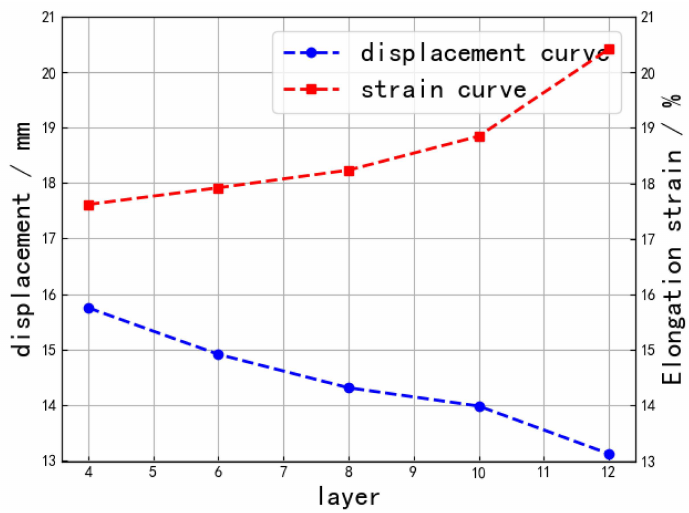
Figure 14. Single-degree-of-freedom simulation of the elongation displacement/strain–film layer curve of the drive